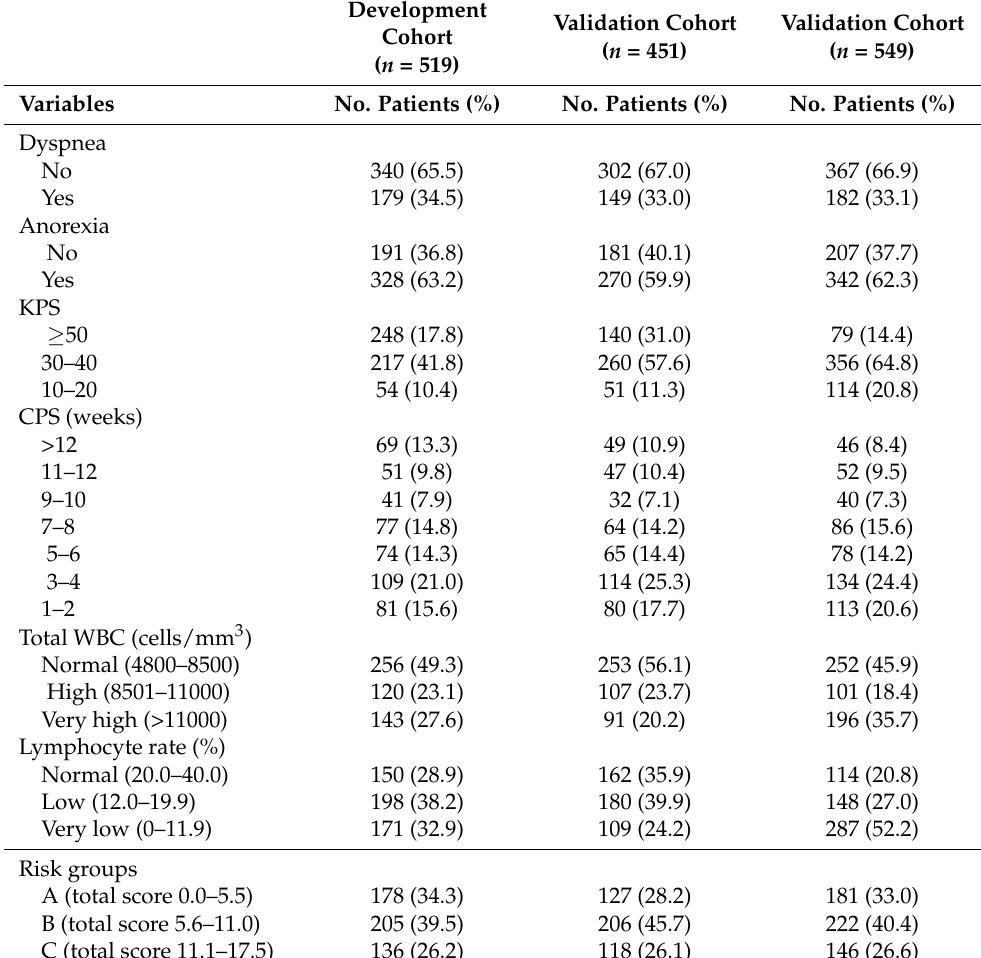
Table 2. PaP score in palliative care